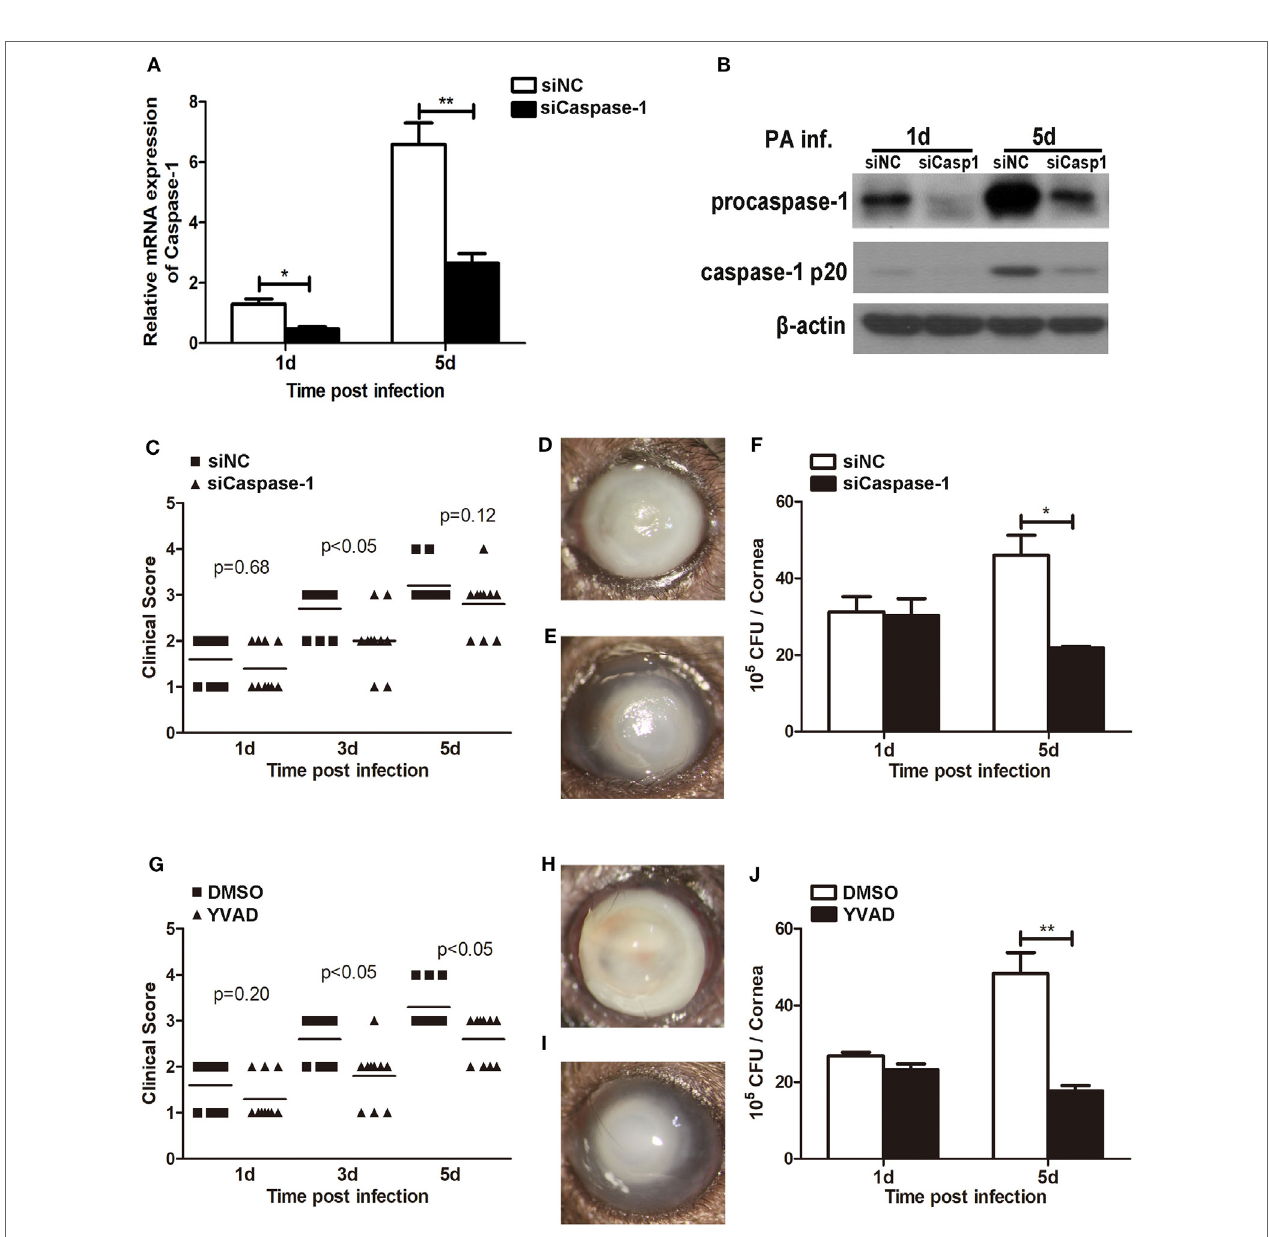
FigUre 4 | Triggering receptors expressed on myeloid cells 2 (TREM-2) inhibited pyroptosis of infiltrating cells in Pseudomonas aeruginosa keratitis. Pyroptosis in the infected cornea assessed with terminal deoxynucleotidyl transferase-mediated uridine 5 ′ -triphosphate-biotin nick end labeling (TUNEL) staining. TUNEL-positive staining (green) was detected in Trem2 − / − (a) versus wild type (WT) (B) corneas at 5 days after infection. Cell nuclei were stained with 4,6-diamino-2-phenyl indole (DAPI; blue). Magnification was 200 and 400 × respectively. (c) The protein levels of GSDMD and its N-terminal domain in Trem2 − / − versus WT B6 corneas were detected with western blot. (D) The percentage of macrophages, polymorphonuclear neutrophils, and dendritic cells were detected by flow cytometry in the infected WT and Trem2 − / − corneas at 5 days post infection. Data were shown to represent one of three individual experiments each with five mice per